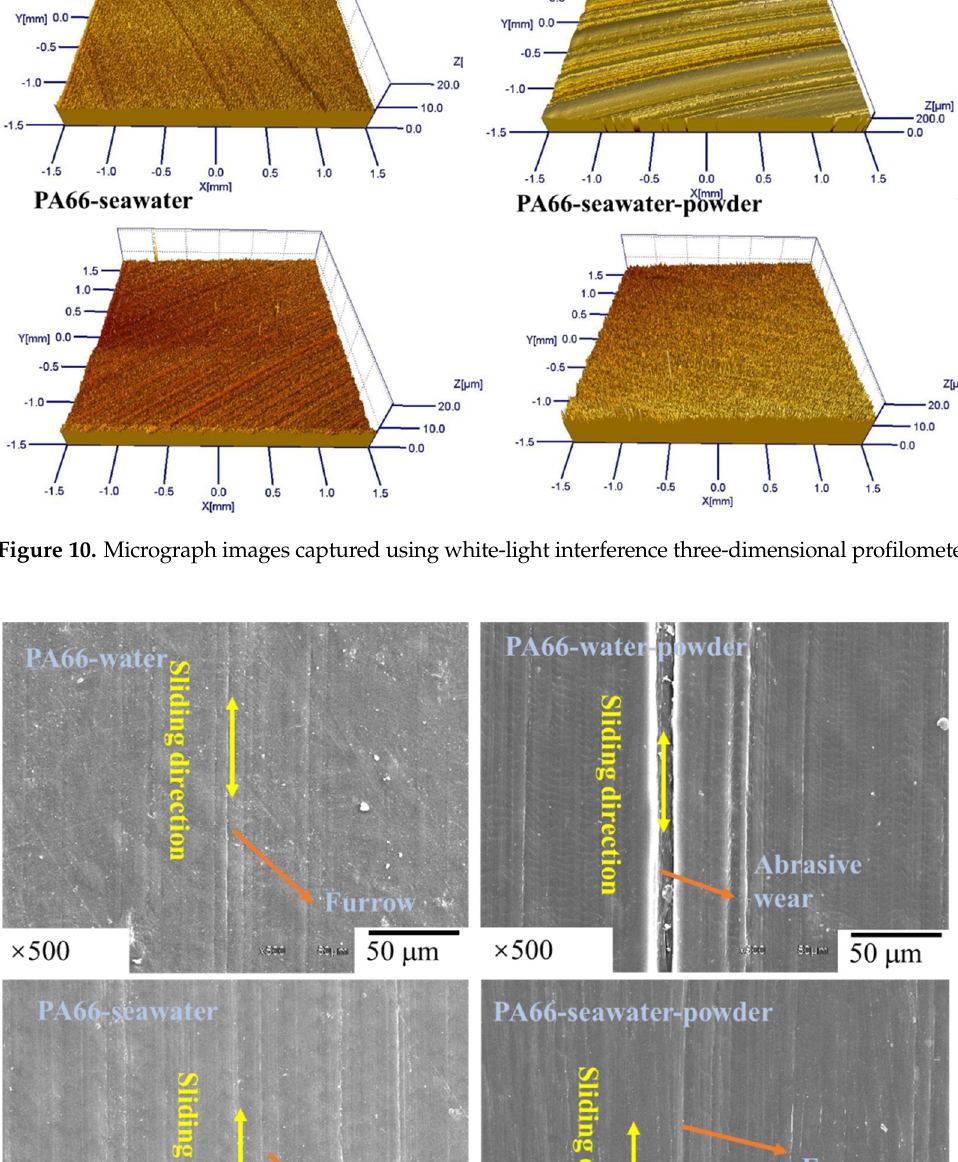
Figure 11. SEM images of PA66 pins. Table 6. The roughness of PA66 pins